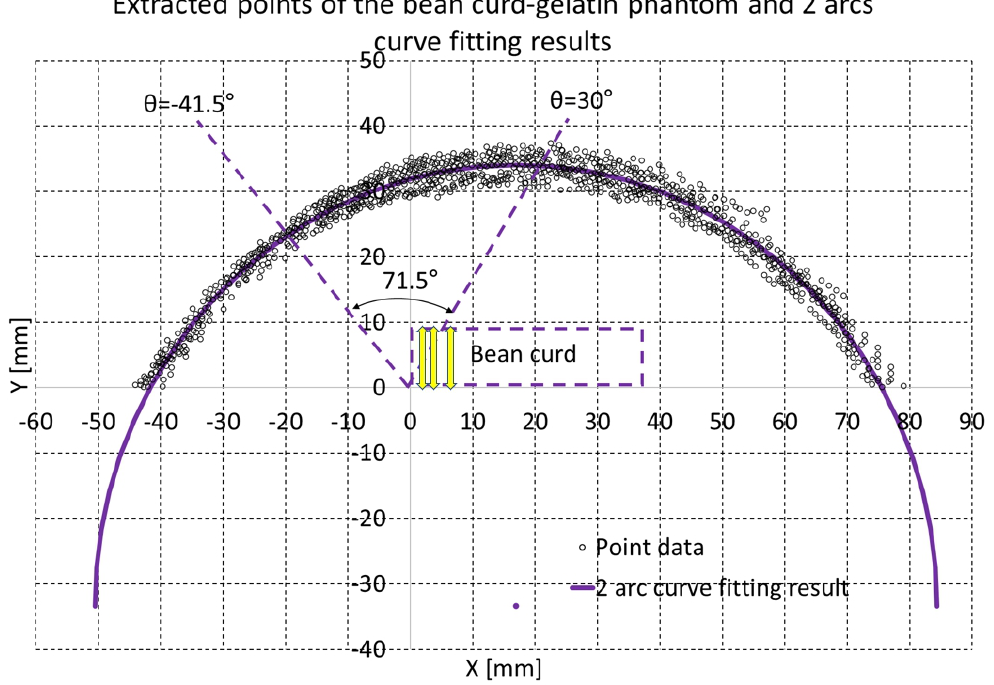
Figure 10. Enhanced piecewise curve fitting results of the bean-curd gelatin phantom (in total, 985